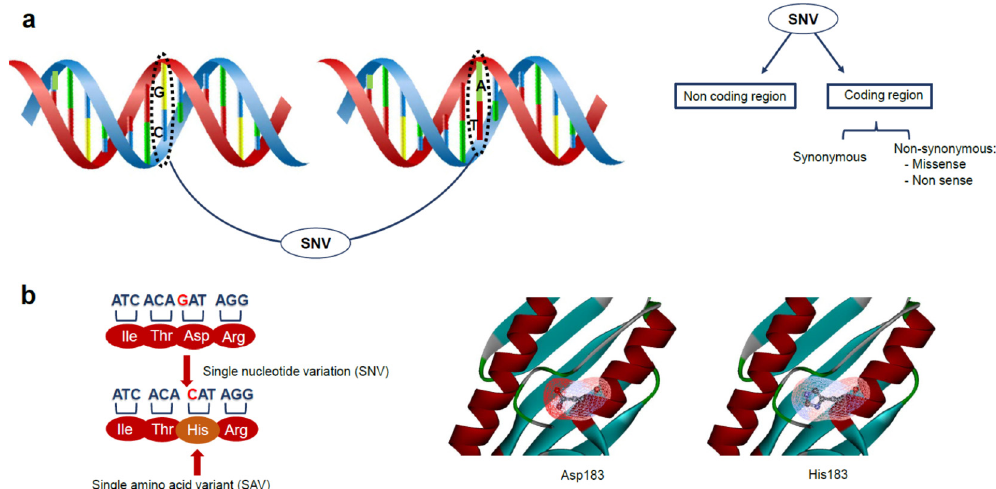
Figure 1. ( a ) Single nucleotide variations (SNVs) can occur in the coding or in the non-coding region. SNVs in the coding region can be synonymous if no amino acid changes are produced, non-synonymous if the single nucleotide substitution induces changes in the protein sequence. Usually, two types of non-synonymous changes can be described: missense mutation, that produces an amino acid change in the protein (SAV) and nonsense mutation which produces a truncated or a longer protein. ( b ) A single nucleotide substitution can lead to a single amino acid change generating a protein variant with structural and/or functional alterations as shown in the substitution of the residue Asp183 with a His in the human frataxin protein (PDB code: 1EKG).